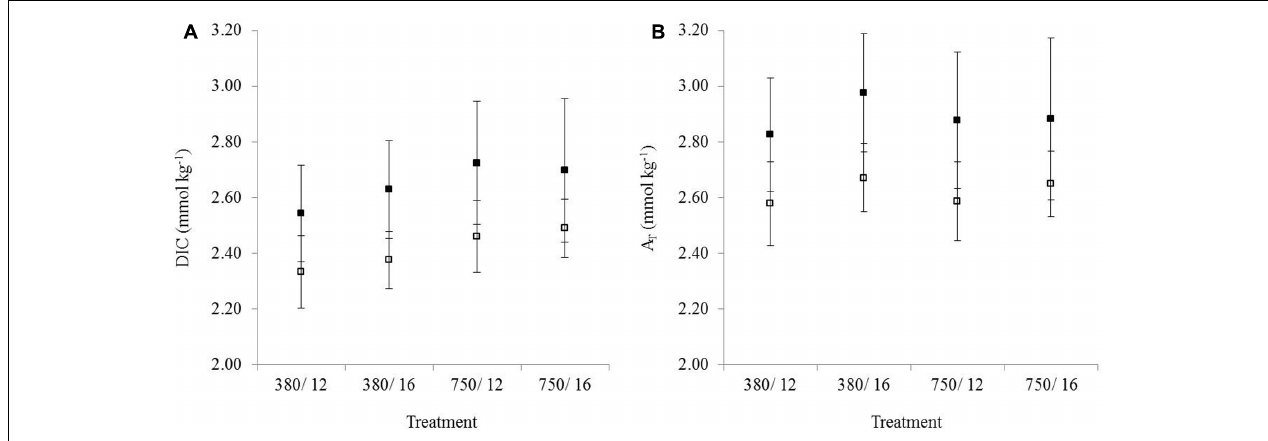
FIGURE 2 | The mean ( n = 3) concentration of (A) DIC (dissolved inorganic carbon) and (B) A T (total alkalinity) from the control and treatment flumes. Error bars represent the standard deviation. Samples were taken from the overlying water in the daytime for muddy sediment (solid black squares) and sandy sediment (white squares). Treatments on the x -axis represent environmental conditions during the experiment.